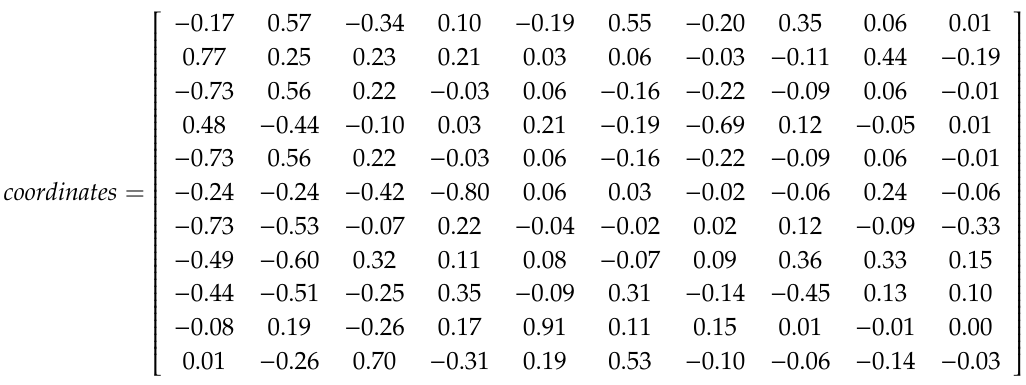
within the unit circle that is indicated in the graph. The closer a variable in this graph falls to the unit circle, the better its representation is by the current coordinate system. Hence, the circle provides a visual indication of how well each observable is represented by the current set of principal